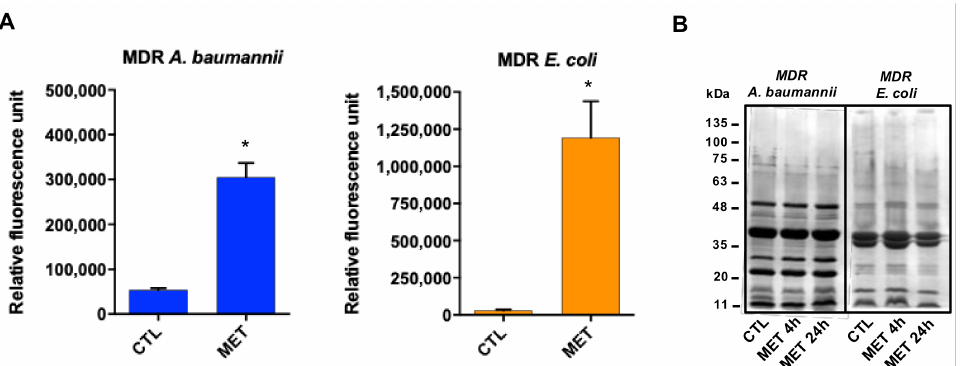
Figure 2. Tamoxifen metabolites present antibacterial activity targeting the bacterial membrane. ( A ) Tamoxifen metabolites effect on the bacterial permeability. The membrane permeabilization of MDR A. baumannii Ab186 and E. coli EcMCR+ strains in absence and presence of tamoxifen metabolites (2 and 16 mg/L, respectively) incubated for 24 h, was quantified by Typhon Scanner. ( B ) SDS–PAGE of the outer membrane proteins of MDR A. baumannii Ab186 and E. coli EcMCR+ strains with or without tamoxifen metabolites (2 and 16 mg/L, respectively). MET: the three tamoxifen metabolites together. CTL: control. * p < 0.05: CTL vs.